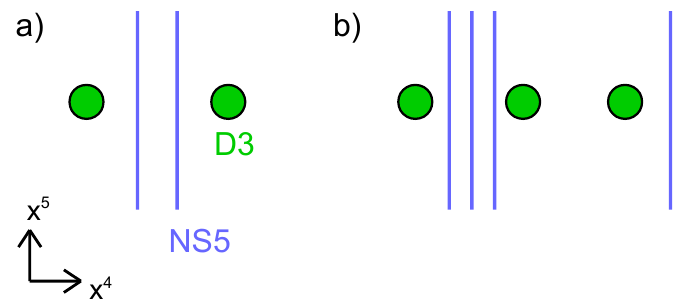
Figure 1 . Brane setups realizing: a) a ’t Hooft loop with magnetic charge (1 ; (cid:0) 1) in the [ S ]U(2) theory. b) a ’t Hooft loop with charge (2 ; (cid:0) 1 ; (cid:0) 1) in the [ S ]U(3) theory. We can ignore the external NS5 in the SU(3) theory.